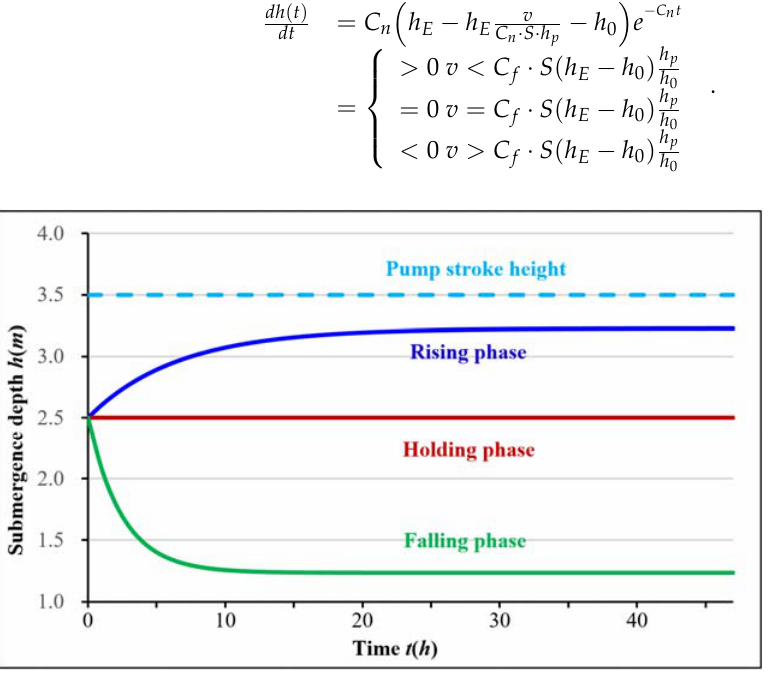
Figure 3. Schematic diagram of three-phase trends of the submergence depth in the nonfull-pumping model.